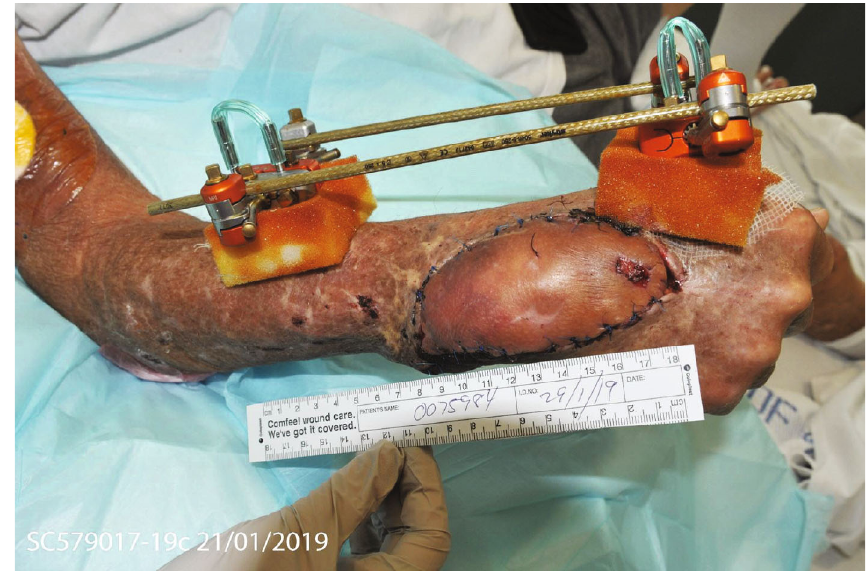
Figure 4: Clinical photograph of the right hand with external fi xation devices in